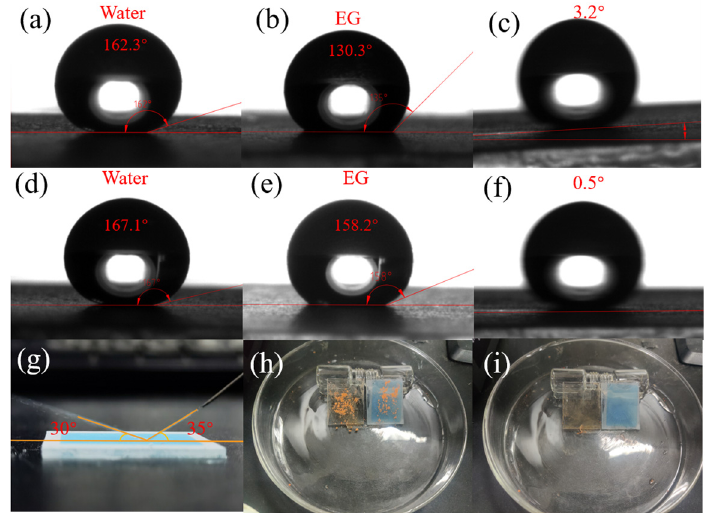
Figure 4. The WCA, EGCA, and WRA on ( a – c ) the stacked substrate and ( d – f ) the F 16 CuPc-modified biomimetic superhydrophobic surface. ( g ) The water column reflects images on the F 16 CuPc-modi- fied biomimetic superhydrophobic surface. Images ( h ) before and ( i ) after the self-cleaning of the glass ( left ) and the F 16 CuPc-modified biomimetic superhydrophobic surface ( right ).